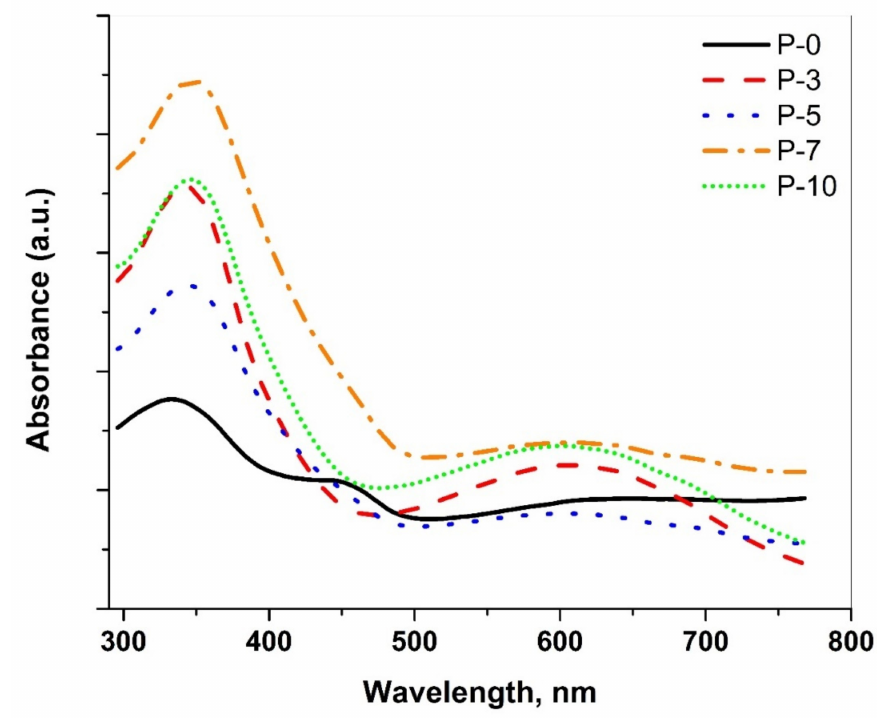
Figure 4. UV-VIS absorption spectra of the investigated PANI/MWCNT